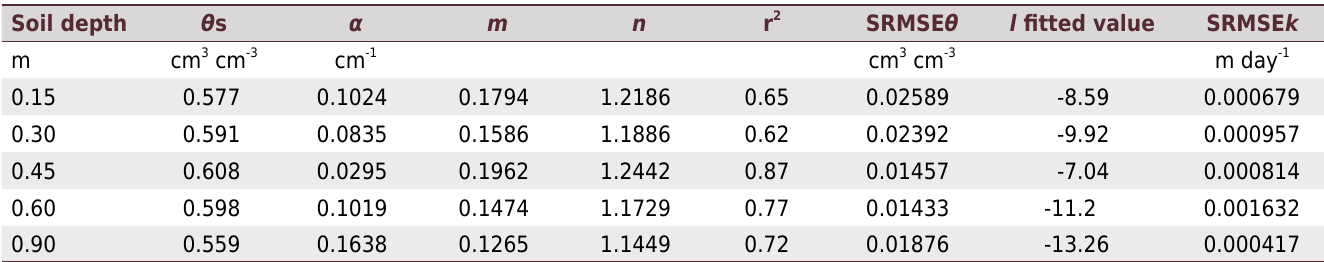
Table 3. Parameters of van Genuchten’s h ( θ ) equation and fitted l parameter of the K ( θ ) relationship Soil